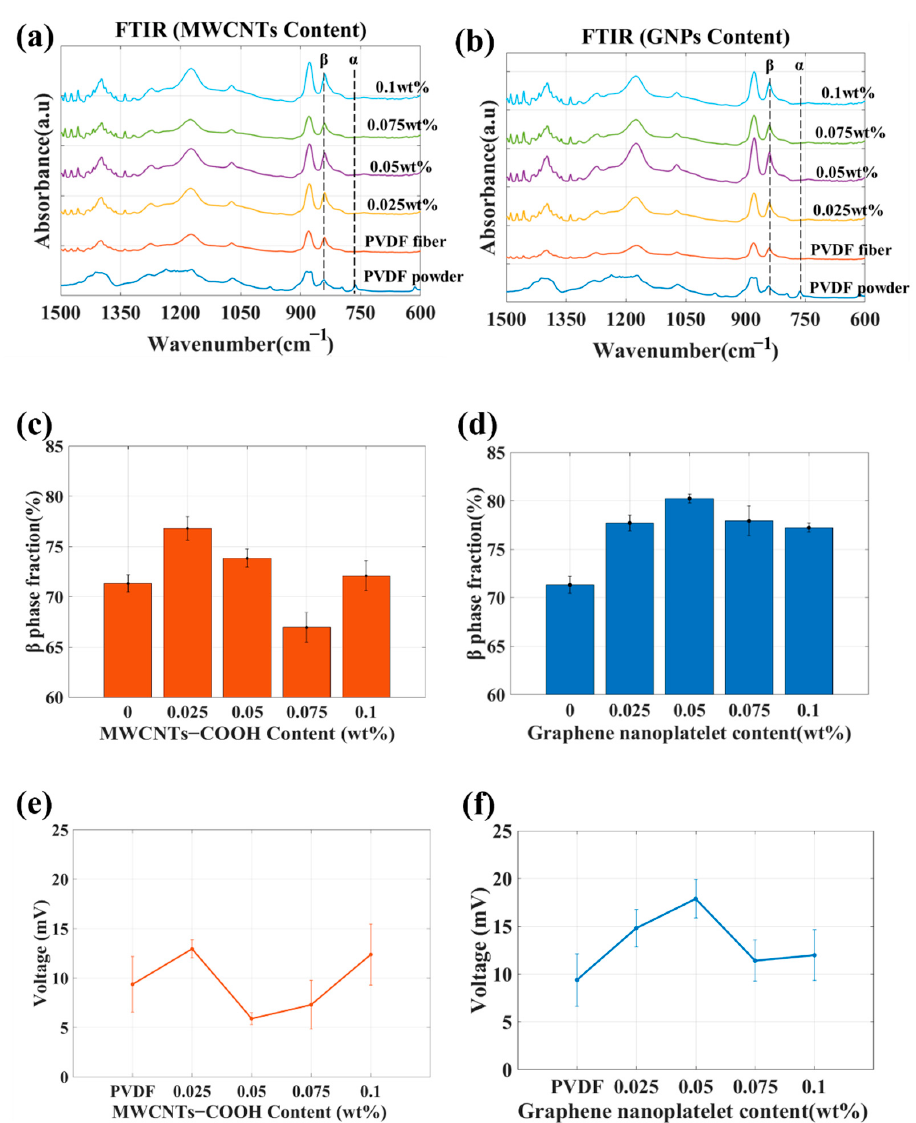
Figure 5. Fourier-transform infrared spectra of electrospun polyvinylidene fluoride composite fibers with ( a ) carbon nanotube or ( b ) graphene nanoplatelet content ranging from 0.0 to 0.1 wt%; relative β -phase content of polyvinylidene fluoride composite fibers with differing ( c ) carbon nanotube or ( d ) graphene nanoplatelet content; electrical output characteristics of electrospun PVDF composite fibers with differing ( e ) carbon nanotube or ( f ) graphene nanoplatelet content.